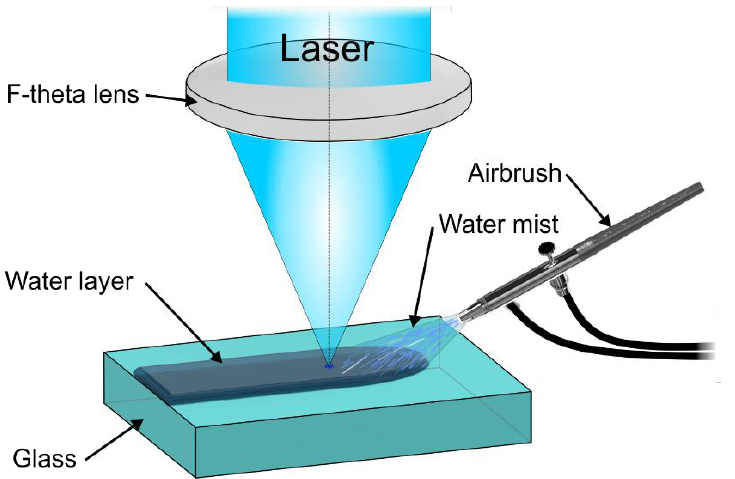
Figure 2. Experimental setup. Airbrush sprayed water mist onto the glass surface, forming thin and flowing water film.